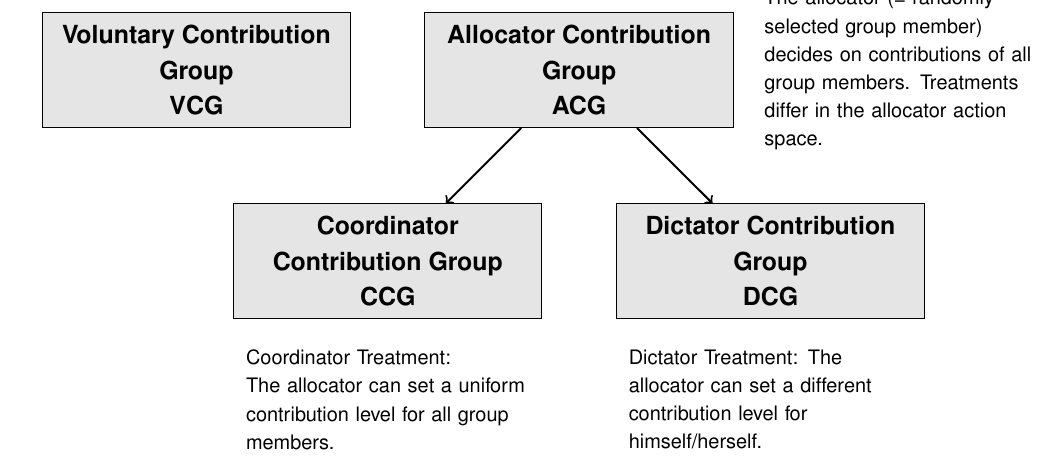
Figure 1. Treatment design and